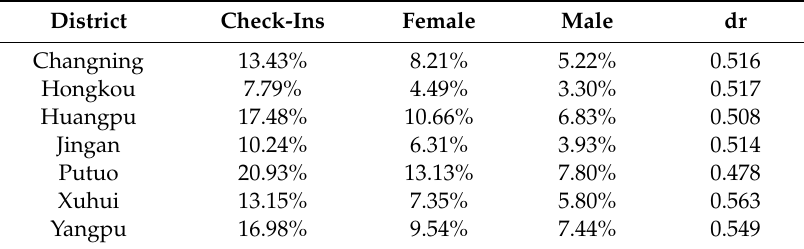
Table 7. Gender di ff erence between the districts.